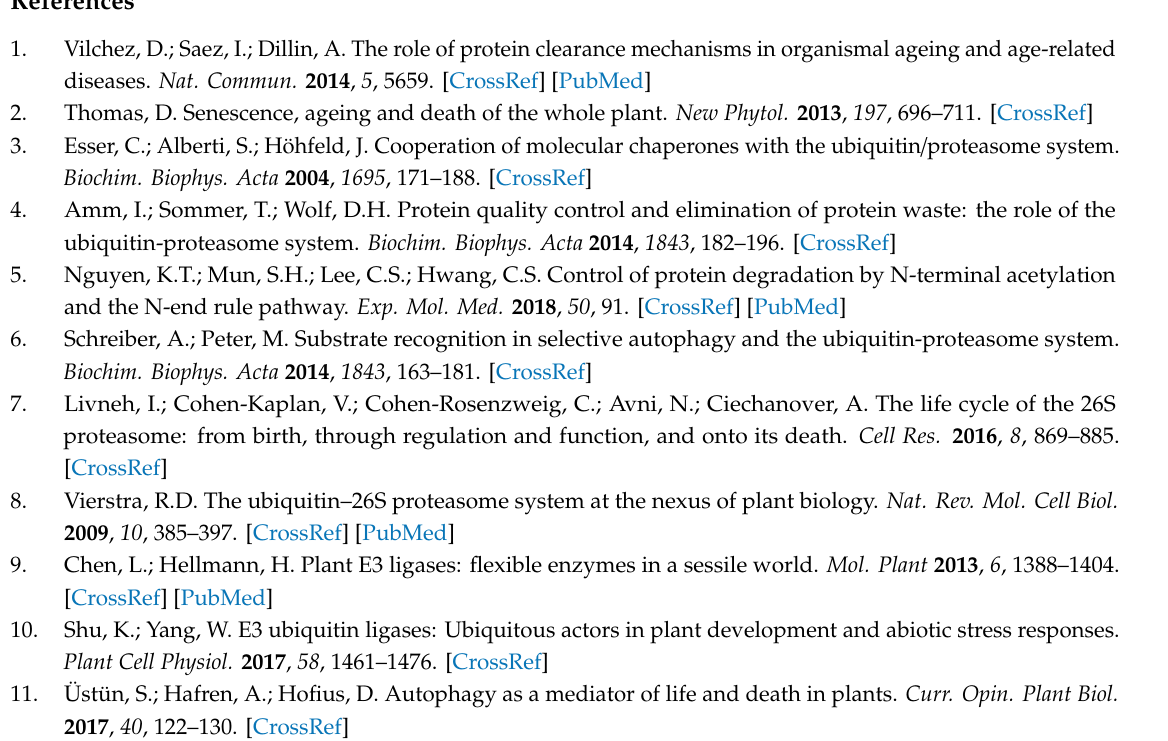
Table S1: Detected PTMs on proteasome subunits of Arabidopsis